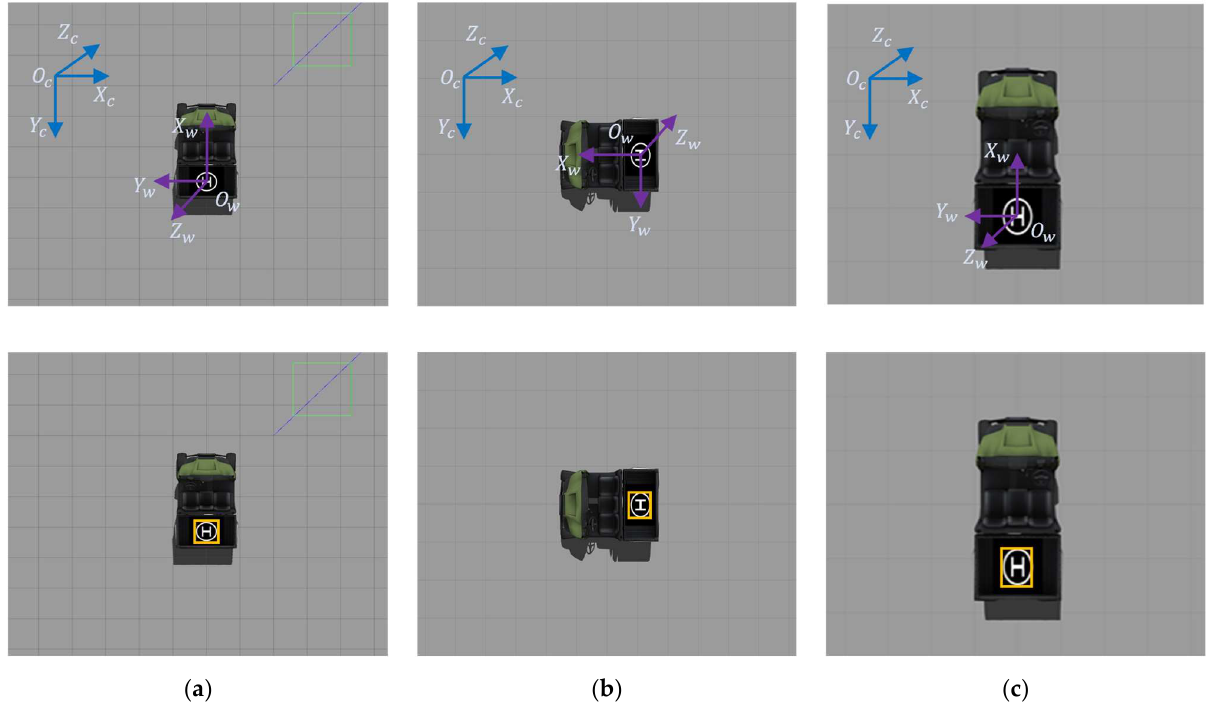
Figure 7. Examples of target images with labels: ( a ) top view angle of 90°; ( b ) yaw angle of 90°; and ( c ) large field-of-view occupancy.